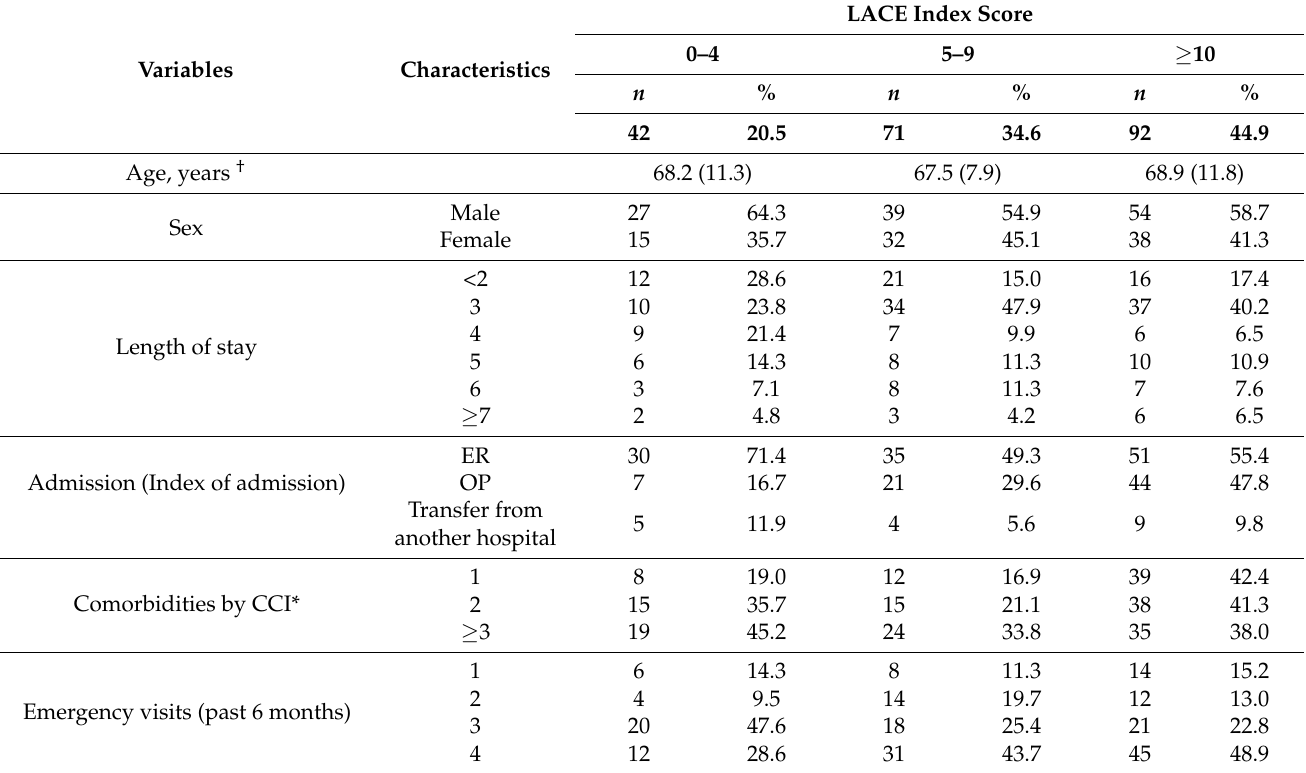
Table 2. Distribution of LACE Score of Patients with AMI and 30-day Readmissions ( n =